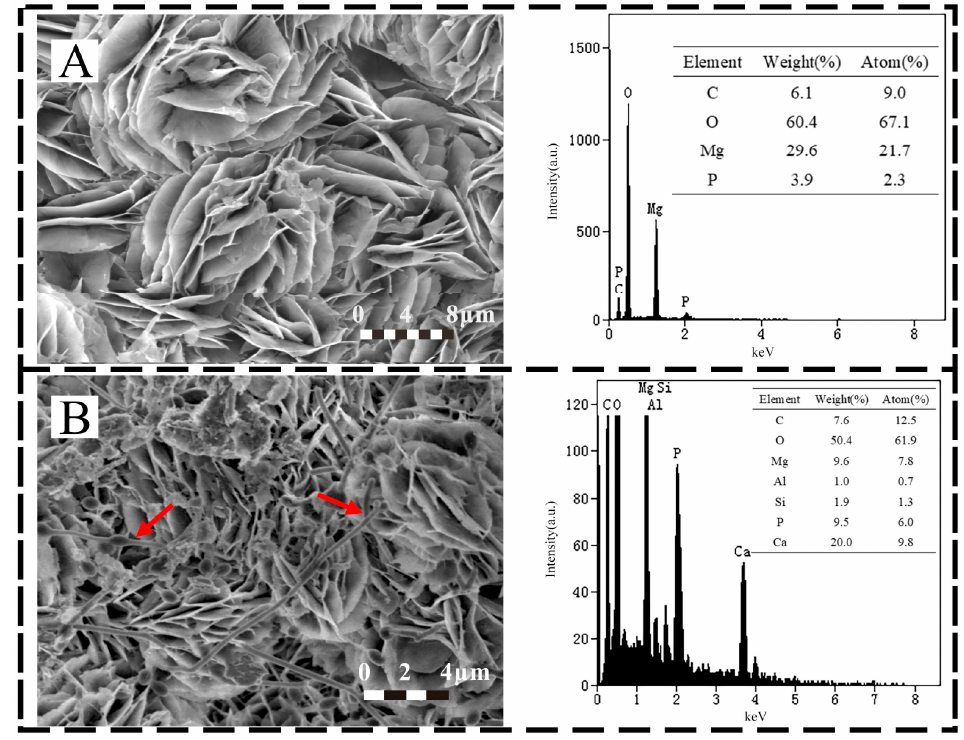
Figure 4. Selected SEM images and EDS analysis before removing the corrosion products on the AZ31B specimen after 14 days immersion under ( A ) abiotic mud ( B ) biotic mud. Arrows in B indicate cells.